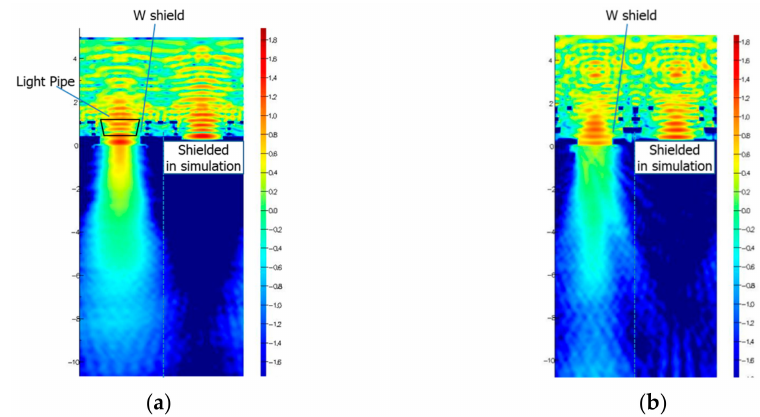
Figure 17. Comparison of electric field of incident light at 850 nm ( a ) with light pipe and ( b ) without light pipe. The right-side pixel is shielded by metal on purpose to extract light intensity only from the left-side pixel into the